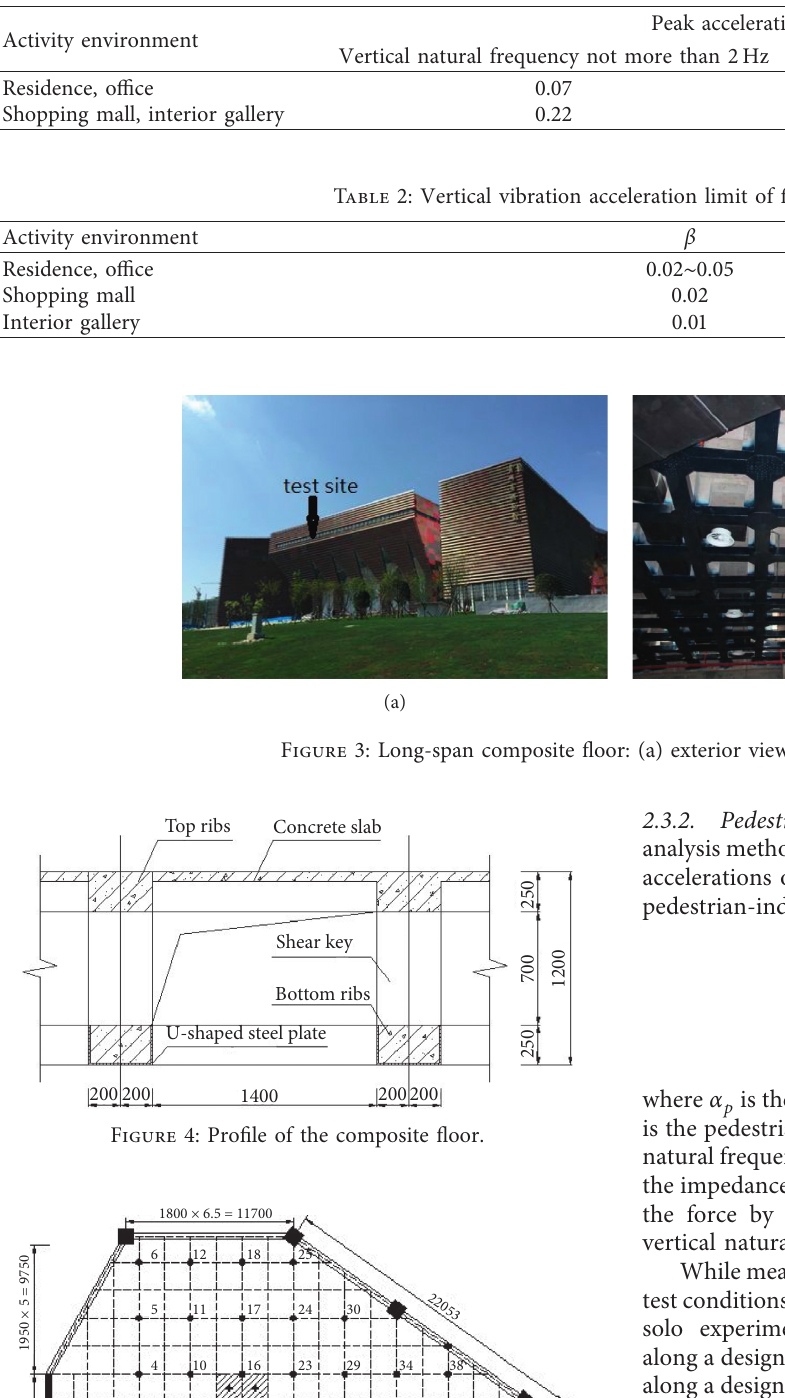
Table 1: Vertical vibration acceleration limit of the